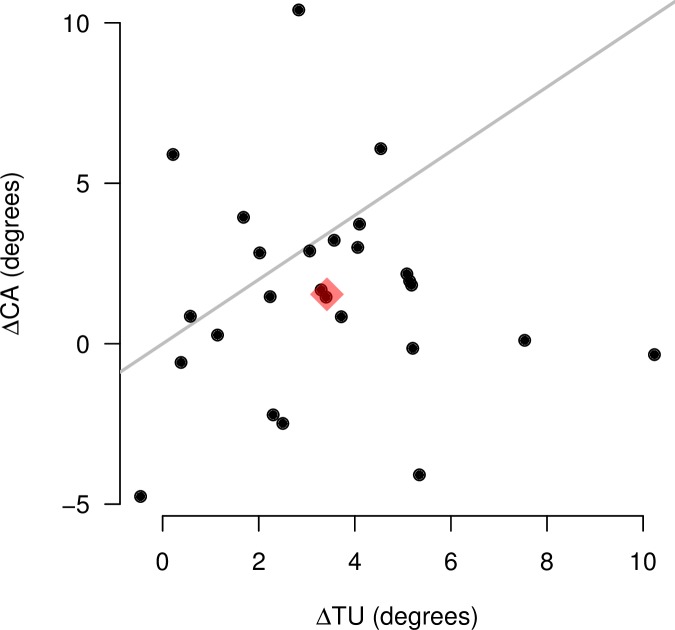
Per-subject differences in angle estimations across background conditions.The difference in the table uprightness (TU) between the rotating and static background is represented in the horizontal axis. The difference in the critical angle (CA) between the rotating and static background, averaged across the three objects, is represented in the vertical axis. The gray line indicates the values for which ΔTU = ΔCA. The red diamond represents the mean population value for both axes.